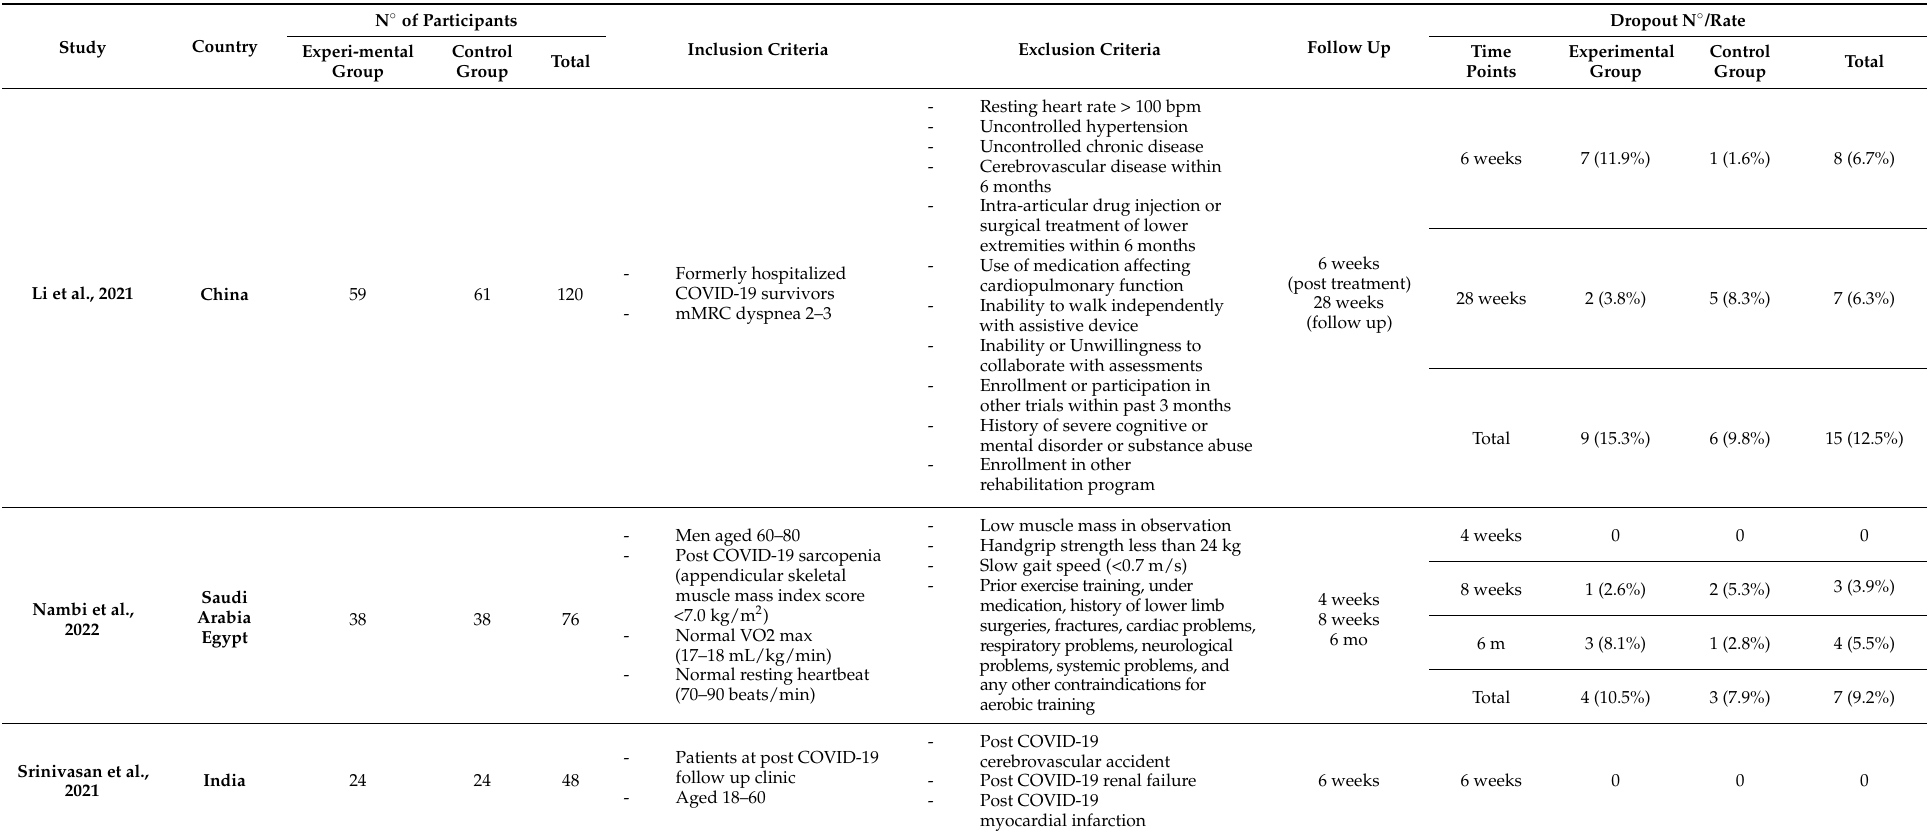
Table 1. Characteristics of included